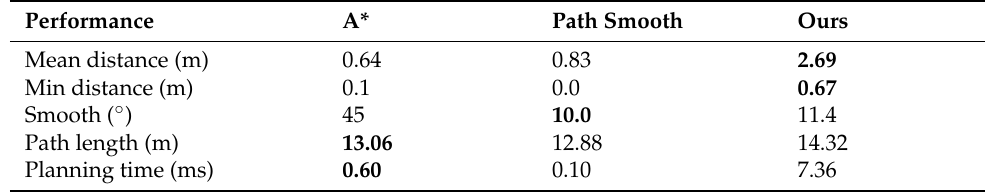
Figure 9. The paths generated by our proposed path-generation algorithm (blue), the Path Smooth algorithm (red), and the A* algorithm (green) in the second experiment. Table 1. The performance index of the generated path in the first